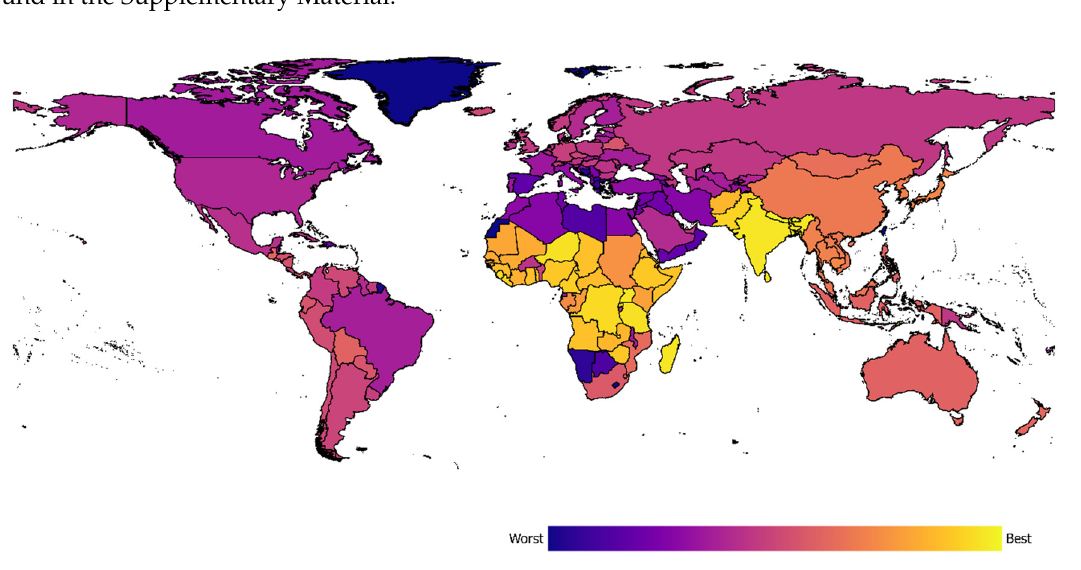
Figure 13. Global view on the literacy dimension.